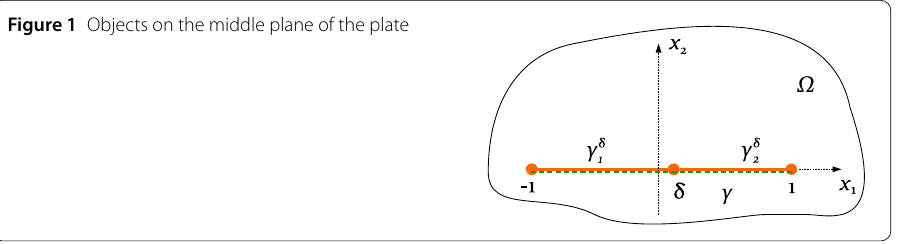
Figure 1 Objects on the middle plane of the